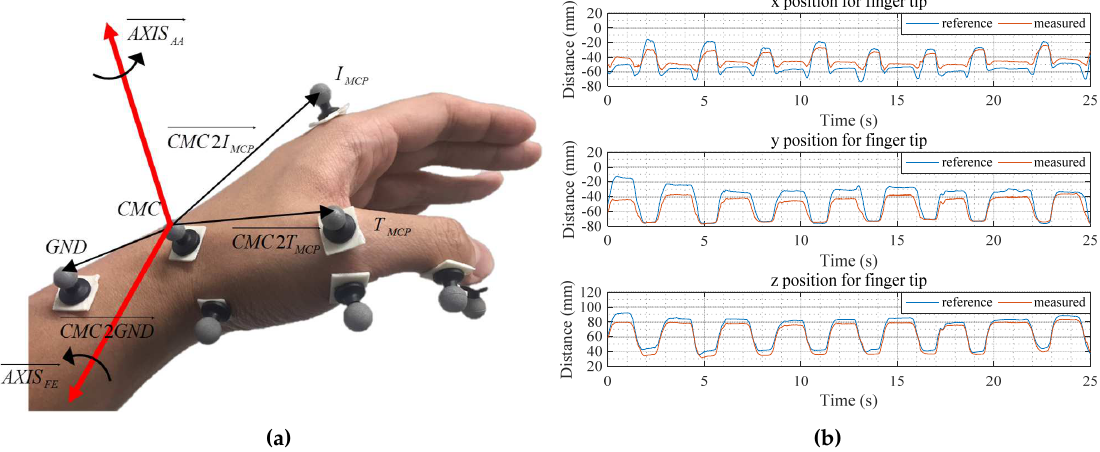
Figure 10. Experimental verification for the thumb finger model; ( a ) Defining rotation axes at the CMC joint; ( b ) Position of the thumb fingertip measured by the proposed model.